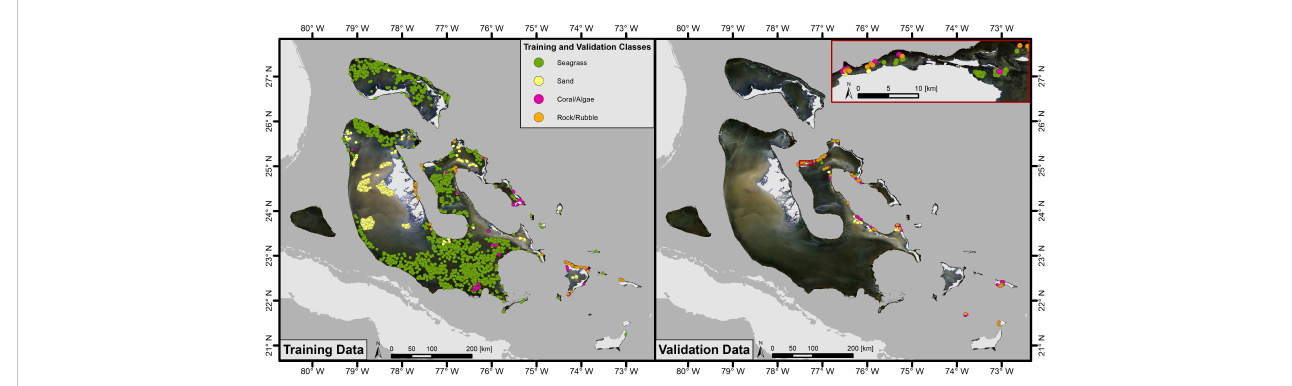
FIGURE 3 Distribution of the 4,400 training data and 1,100 validation data points of the four classes used in the supervised machine learning classi fi cation.